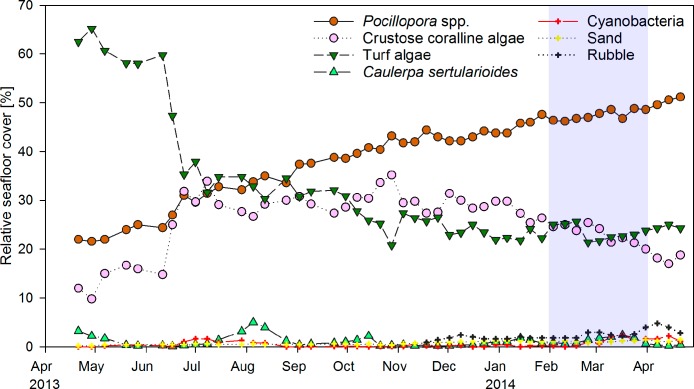
Temporal changes in coral reef community composition.Displayed is the mean proportional cover of benthic organisms or substrates in permanent quadrats of 50 × 50 cm (n = 5) from April 2013 to April 2014 in a weekly resolution. Shading indicates the period of strongest upwelling in February and March (see Fig. 4).